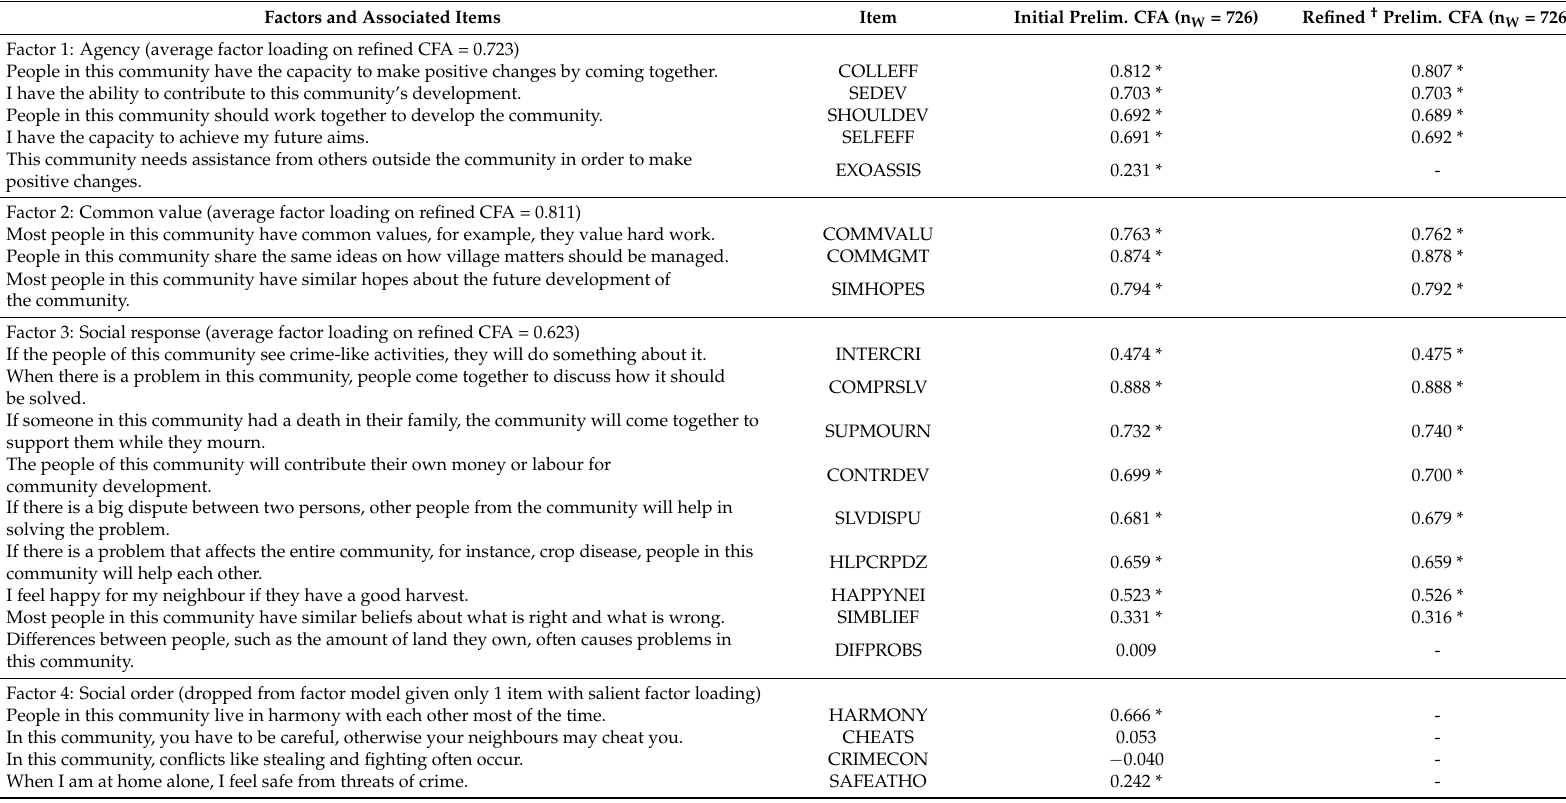
Table A3. Factor Loadings from Preliminary CFA of Our Hypothesised CE Framework, Women. Factors and Associated